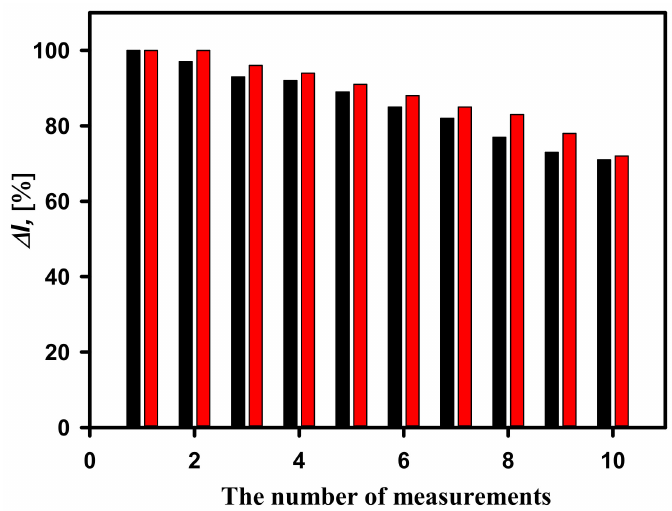
Figure 5. Current responses of the developed biosensors based on GA-GOx-SAM/DGNs/GR elec- trode (red columns) and GA-GOx/DGNs/GR electrodes (black columns) during repeated analyte detection. The current response was recorded at 25 mM of glucose